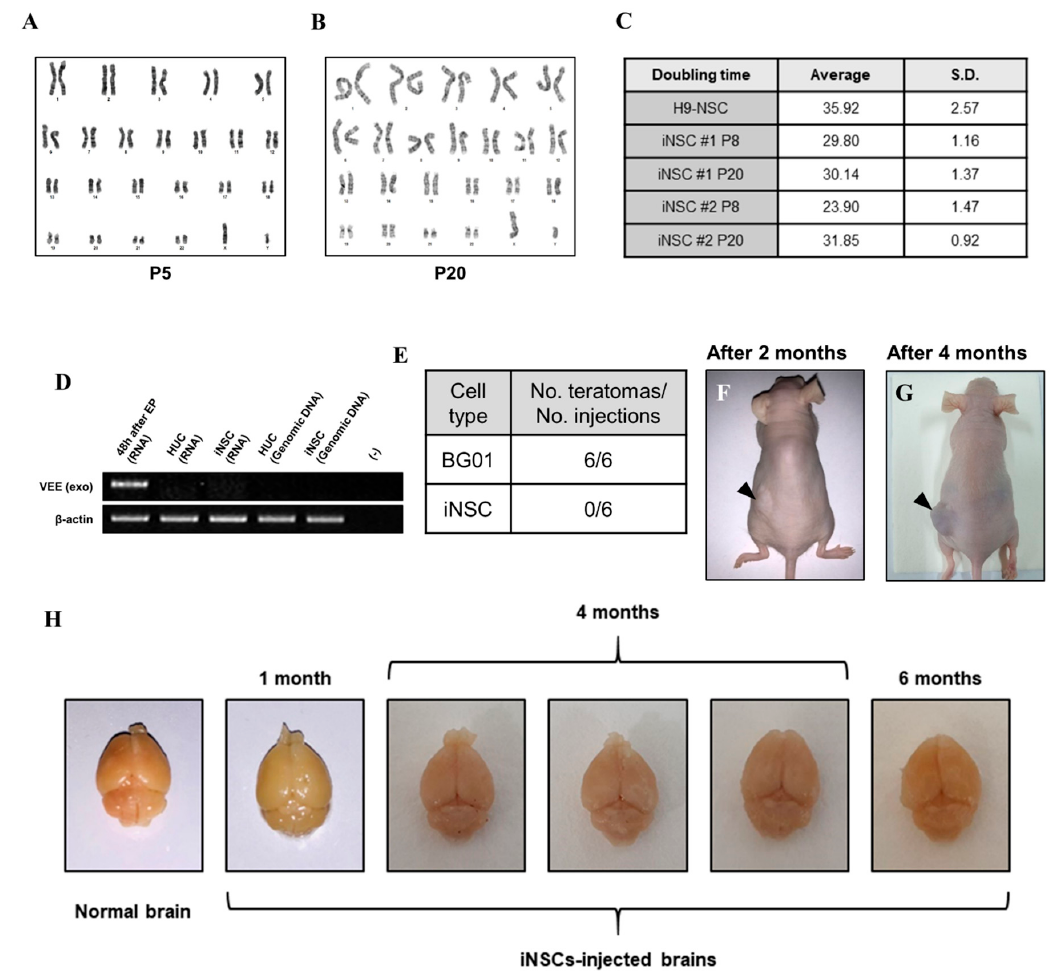
Figure 7. Biosafety evaluations of iNSCs. ( A , B ) Karyotyping of iNSCs at early (P5) and late (P20) passages. ( C ) Doubling time of iNSCs at early (P8) and late (P20) passages. ( D ) Exogenous Venezuelan equine encephalitis (VEEs) are not detected in total RNA and genomic DNA of iNSCs, as demonstrated by RT-PCR. ( E ) Teratoma formation efficiency of BG01-ESCs and iNSCs. ( F , G ) Teratoma formations in nude mice upon injecting 1 × 10 6 BG01-ESCs in left dorsal flank and 1 × 10 6 iNSCs in right dorsal flank. Black arrows indicate teratoma formations two months and four months after injection. ( H ) Morphological analysis of injected iNSCs into brain of nude mice. All mice did not die before sacrifice and no malignant appearances are showed in their brains at one month, four months, and six months after transplantation of